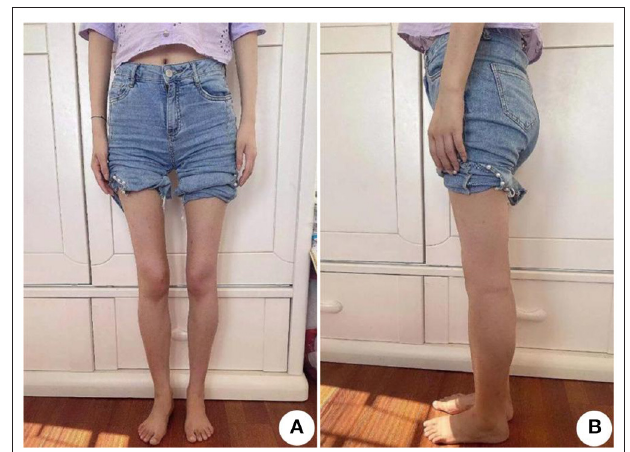
FIGURE 2 | Muscle atrophy in the limbs of the patient, especially the proximal lower limbs. (A) Front view and (B) Side view.